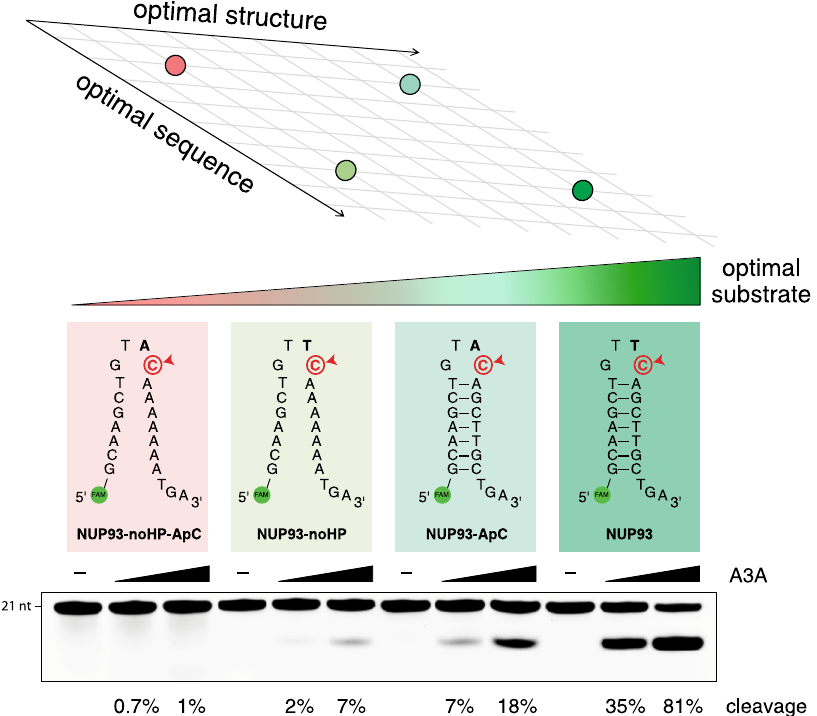
Fig. 1 Primary sequence and secondary structure contribute additively to APOBEC3A substrate optimality. Four substrates are compared, each a version of the DNA hairpin site in the human NUP93 gene. In vitro APOBEC3A activity assay shows that APOBEC3A substrate optimality increases as the DNA sequence improves in optimality (changing an ApC site to a TpC site), and also as the DNA structure improves in optimality (changing from a non- hairpin site to a hairpin site). Strongest activity is seen when both sequence and structure are optimal. Source data are provided as a Source Data fi